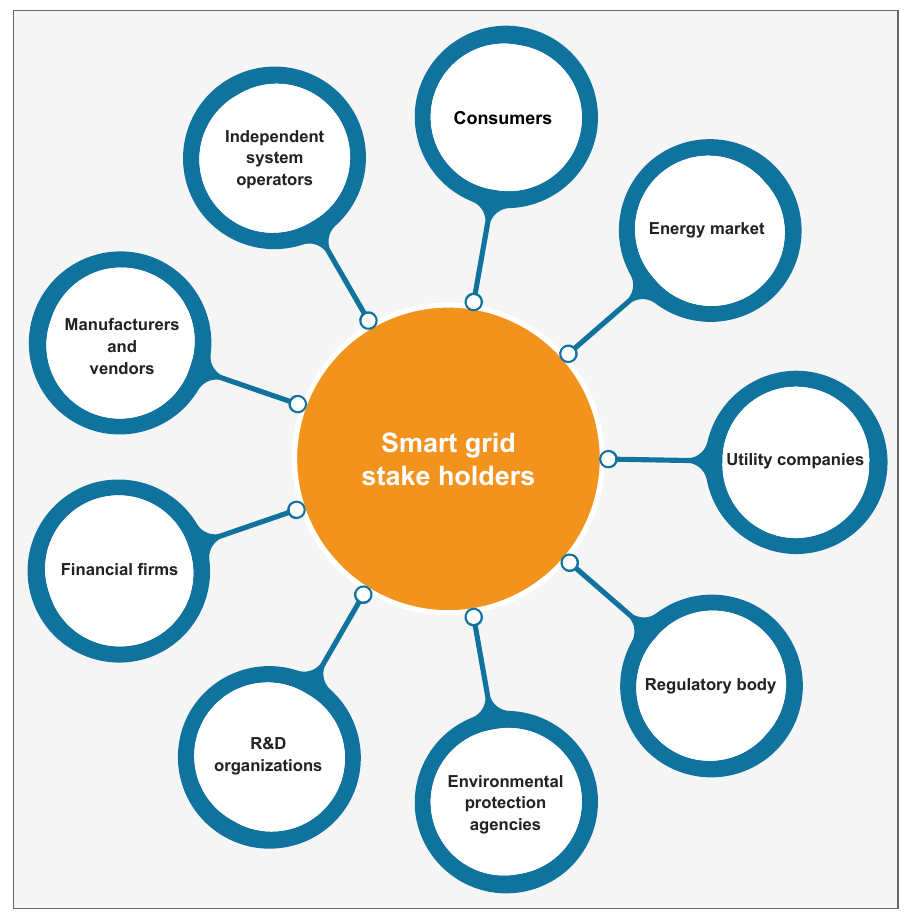
Figure 1. Smart grid